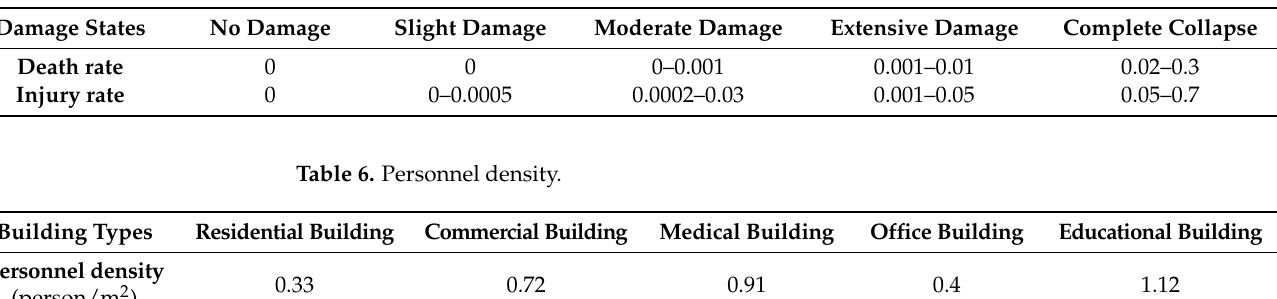
Table 5. Deaths and injury rates.